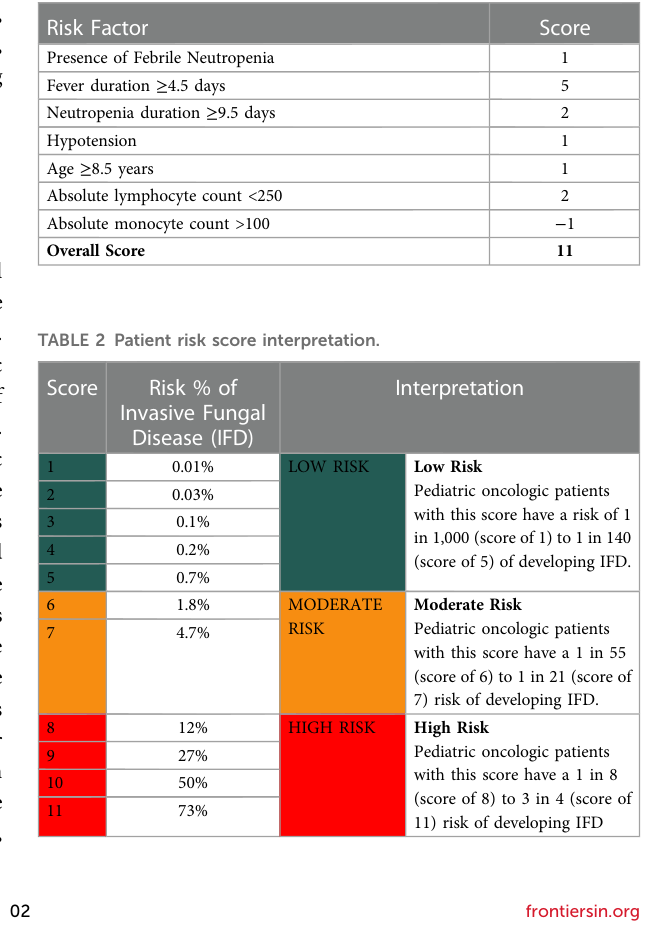
TABLE 1 Risk score for pediatric invasive fungal disease.